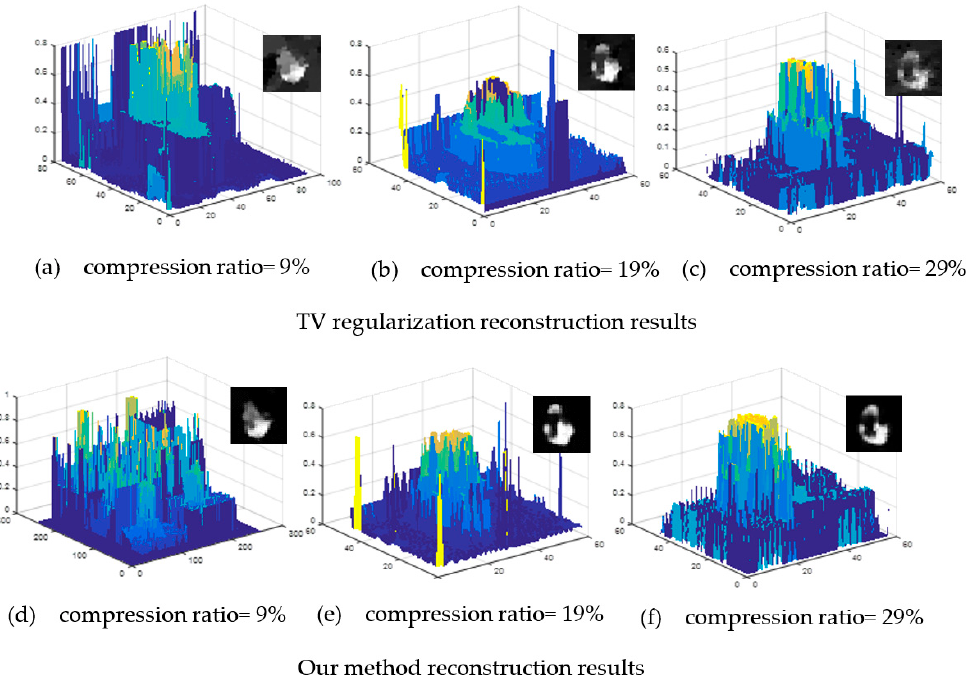
Figure 13. Reconstruction algorithm comparisons: ( a – c ) TV regularization reconstruction results at different compression ratios and ( d – f ) our method reconstruction results at different compression ratios.